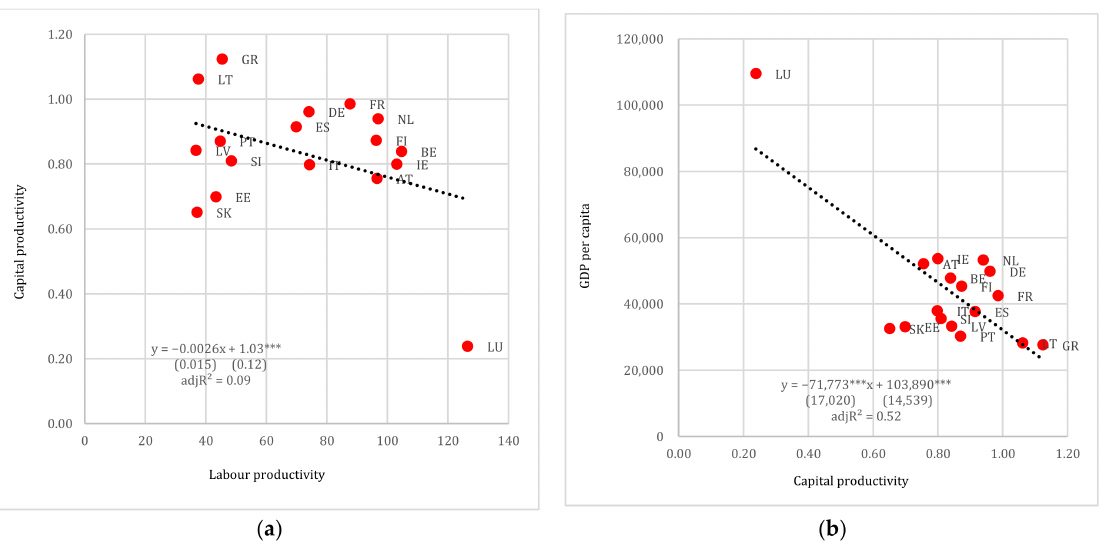
Figure 12. ( a ) Labour productivity vs. capital productivity and ( b ) capital productivity vs. GDP per capita (in USD pps), Eurozone. Note: Standard errors reported in parentheses. *** denotes 1% levels of statistical